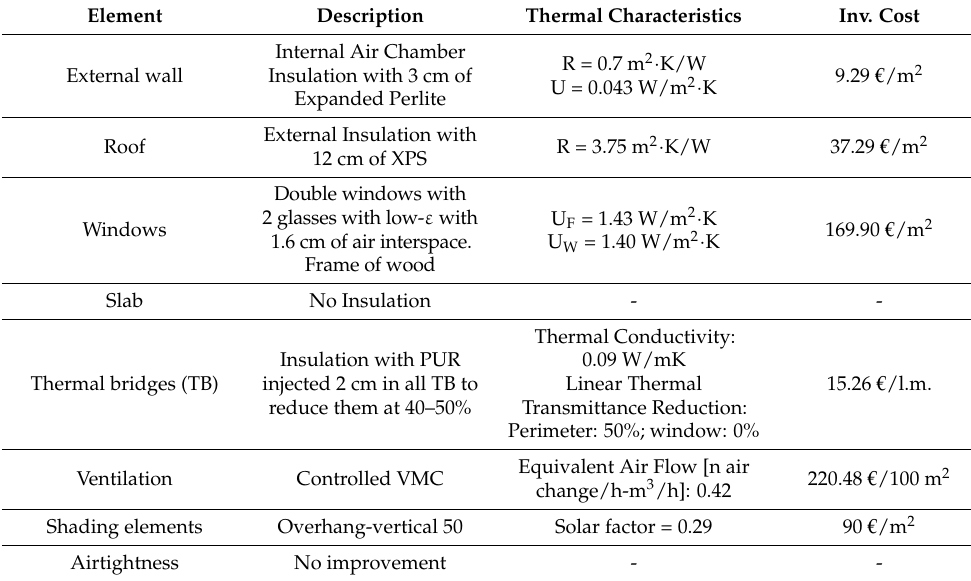
Table A7. POS9s: Renovation measures of solution